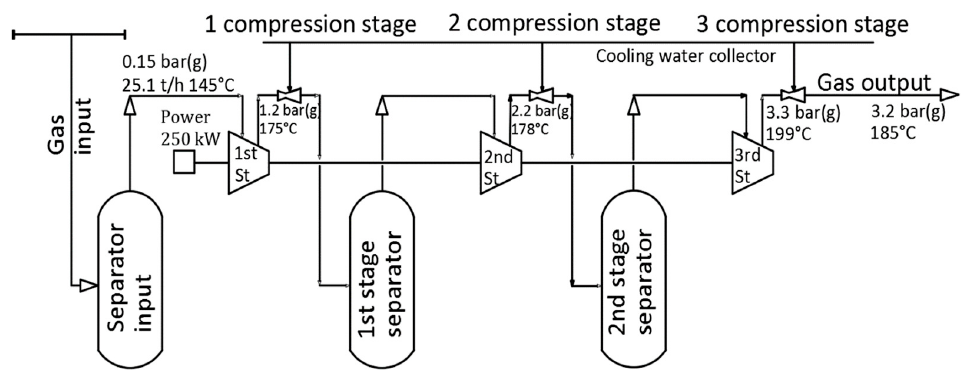
Figure 10. Schematic diagram of operation compression system for the HP integration in the first case.